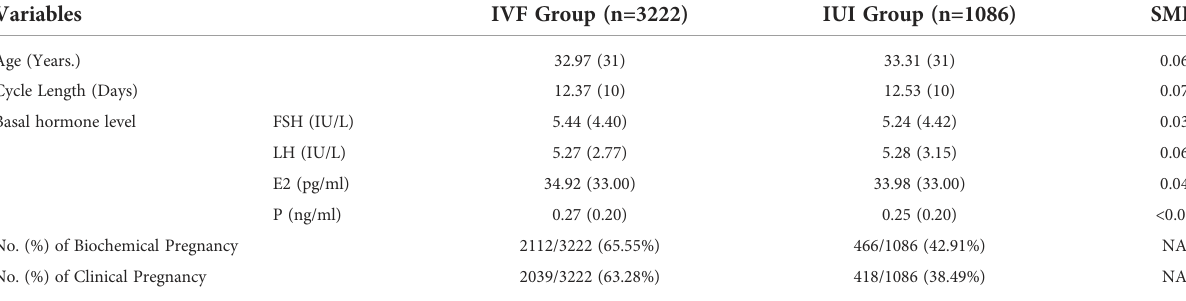
SMD, standardized mean difference. In both IVF Group and IUI Group stands for number of patients included. Biochemical and clinical pregnancy rates in IVF group are pregnancy rates after a IVF cycle including ovum pick up and embryo transplantation, while biochemical and clinical pregnancy rates in IUI group are cumulative pregnancy rates after